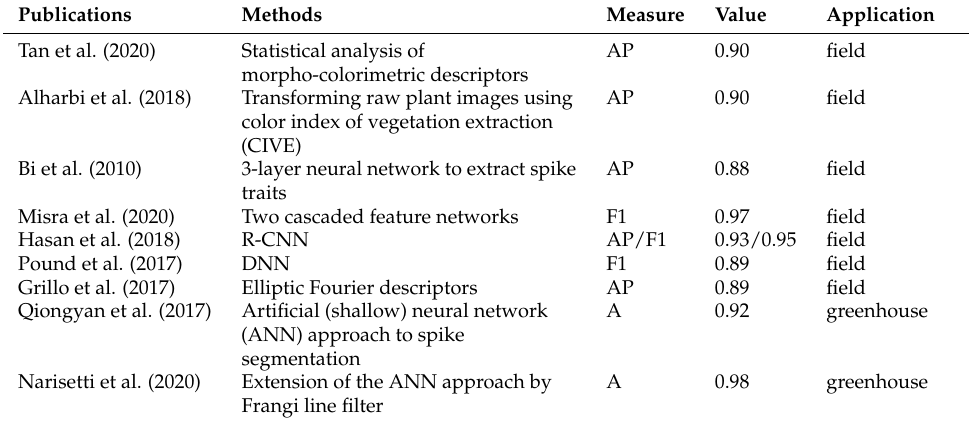
Table 1. Summary of previous works on spike image analysis under field and greenhouse conditions, including the reference to publication, methods, accuracy measures/values as well as the application (field or greenhouse phenotyping). In different studies, different evaluation measures, including average precision (AP), accuracy of the confusion matrix (A) and/or F1-score (Dice coefficient), were